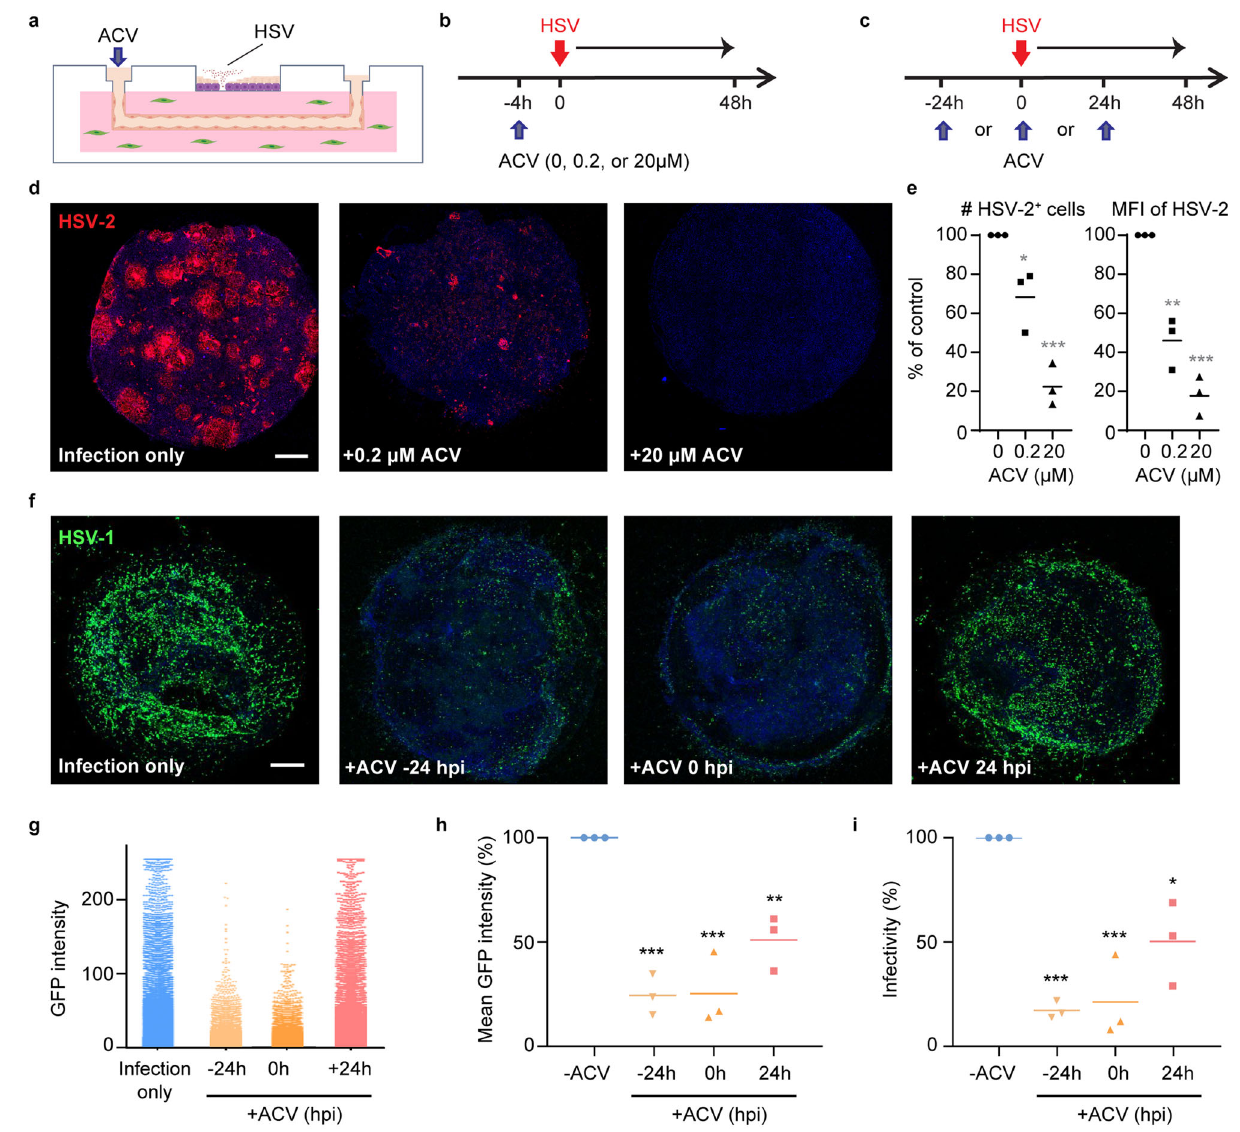
Fig. 7 | Perfusion of acyclovir (ACV) through microvascular network inhibits epidermal HSV infection. a Schematic of HSV epidermal infection and antiviral drug ACV perfusion. b ACV perfusion through the microvasculature at the con- centrations of 0, 0.2, or 20 µ M, 4h before the epidermis was infected with HSV-2 (10 6 PFU). Skin-on-chip was fi xed and stained for HSV gene expression 48h post infection. c ACV perfusion (20 µ M) at time points either 24h prior HSV infection, immediatelyfollowinginfectionor24haftertheepidermiswasinfectedwithHSV-1 K26 (10 6 PFU). Skin-on-chip was fi xed and stained 48h after infection. d HSV infection in the epidermis under ACV perfusion at different concentrations as described in ( b ). Maximum intensity projection of stacked confocal images. HSV-2 (red), DAPI (blue). Scale bar: 500 µ m. e Number of infected cells (* p =0.0298, *** p =0.0003) and MFI (** p =0.0011, *** p =0.0001) of HSV gene expression in